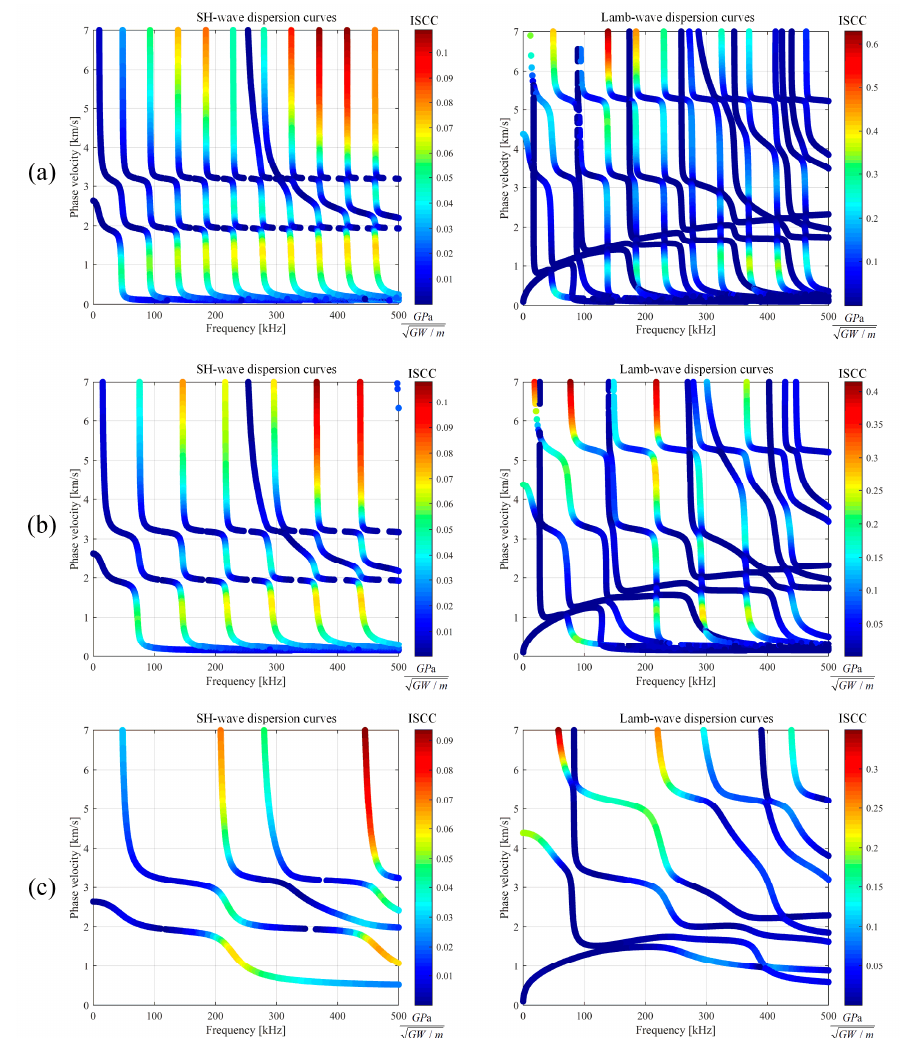
Figure 4. Example of ISCC values superimposing on dispersion curves of SH waves (left) and Lamb waves (right), applying to three Young’s moduli of coating: ( a ) 20 MPa; ( b ) 50 MPa; ( c ) 500 MPa.